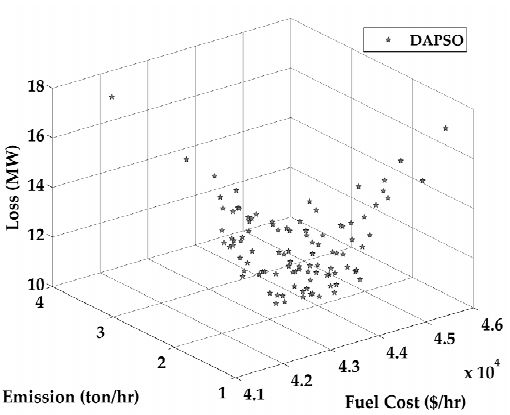
Figure 9. Three-dimensional Pareto fronts when considering fuel cost, emissions, and transmission losses as part of the objective function for the IEEE 57 -bus system.